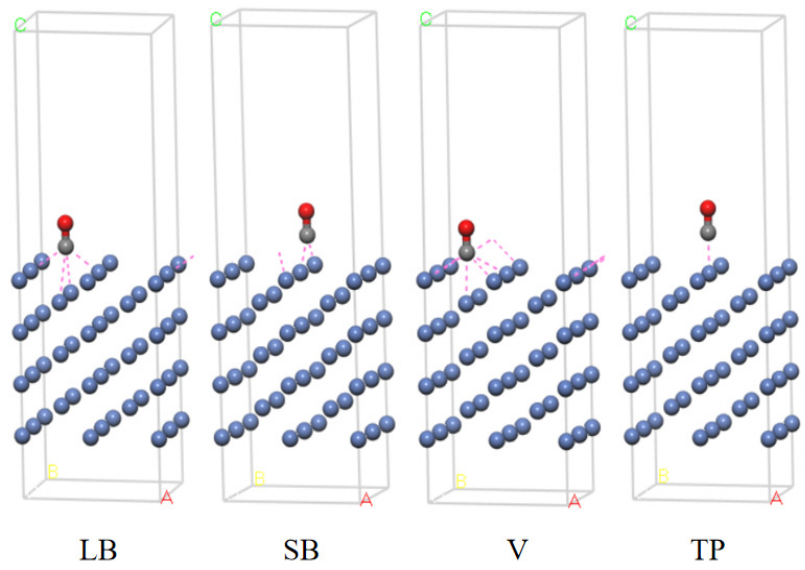
Figure 4. Four adsorption models of CO on Ni (110) crystal surface.